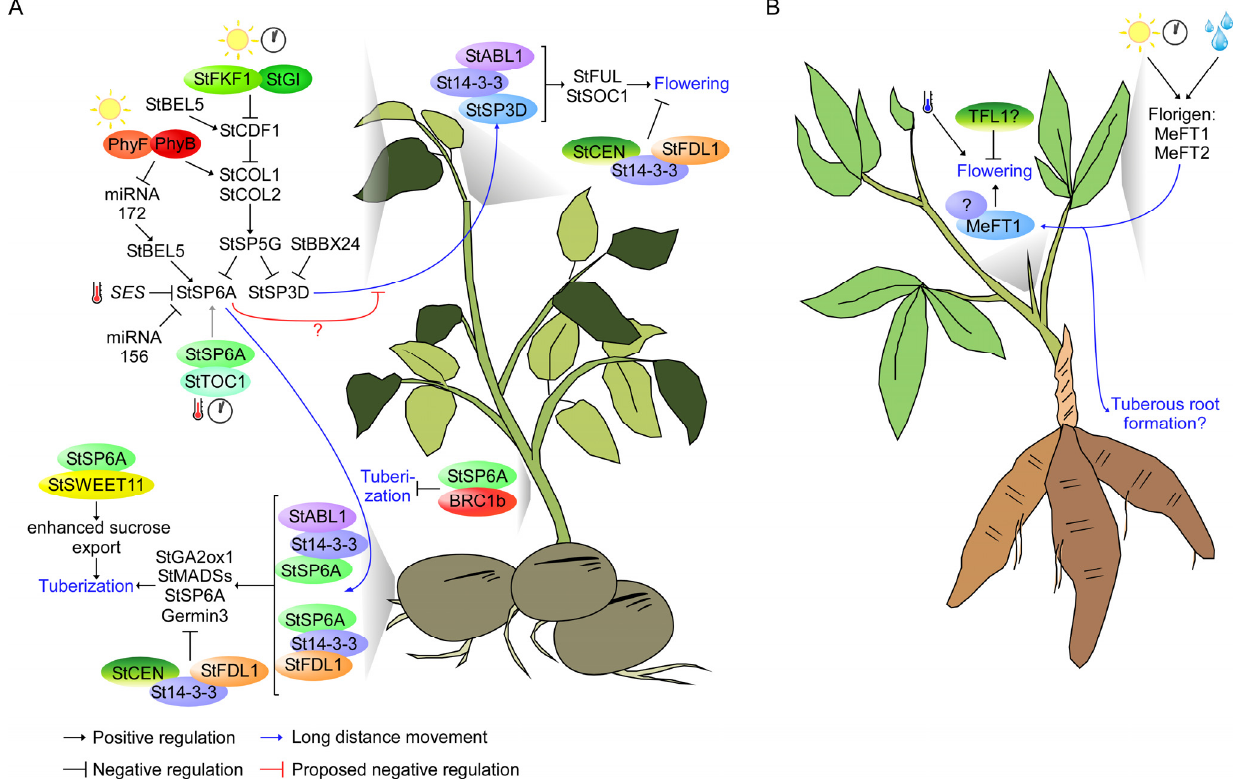
Figure 3. Schematic representation of PEBP signaling network in potato and cassava. ( A ) Schematic representation of flowering time and underground storage organ formation in potato. Internal and external cues modulate PEBP expression, including StSP5G, StSP3D, and StSP6A . StSP3D undergoes long-distance movement to the SAM to initiate flowering, while StSP6A moves to the stolon to promote tuber formation. Another PEBP, StCEN, acts oppositely to prevent floral initiation and tuber formation. ( B ) Schematic representation of flowering time and underground storage organ formation in cassava. External cues, including photoperiod and drought, promote the expression of florigens, MeFT1 and MeFT2 , to modulate flowering